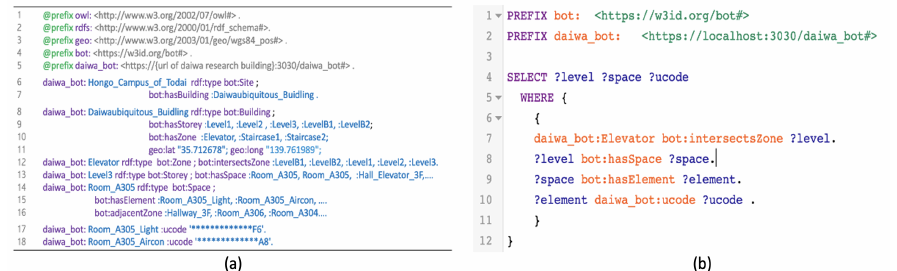
Figure 5. ( a ) The triple value examples of our data store, using the turtle format of RDF metadata; ( b ) SPARQL query example of our proposal.